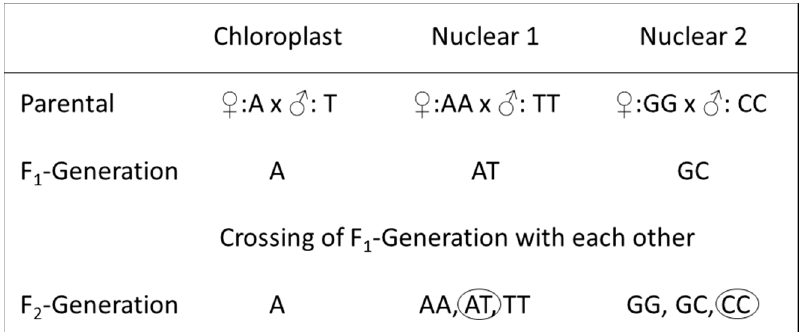
Figure 3. Scheme of a hypothetical genealogy. Presentation of the genealogy of a hybrid by using two different parental species, both homozygous in two different hypothetical markers. Circles in the row “F 2 -Generation” show a possible combination of two markers, one heterozygous and one homozygous, allowing the identification of the hybrid as a F 2 generation. For details, see main text.